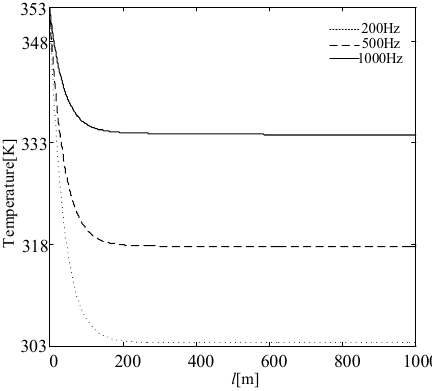
Figure 4. Temperature distribution